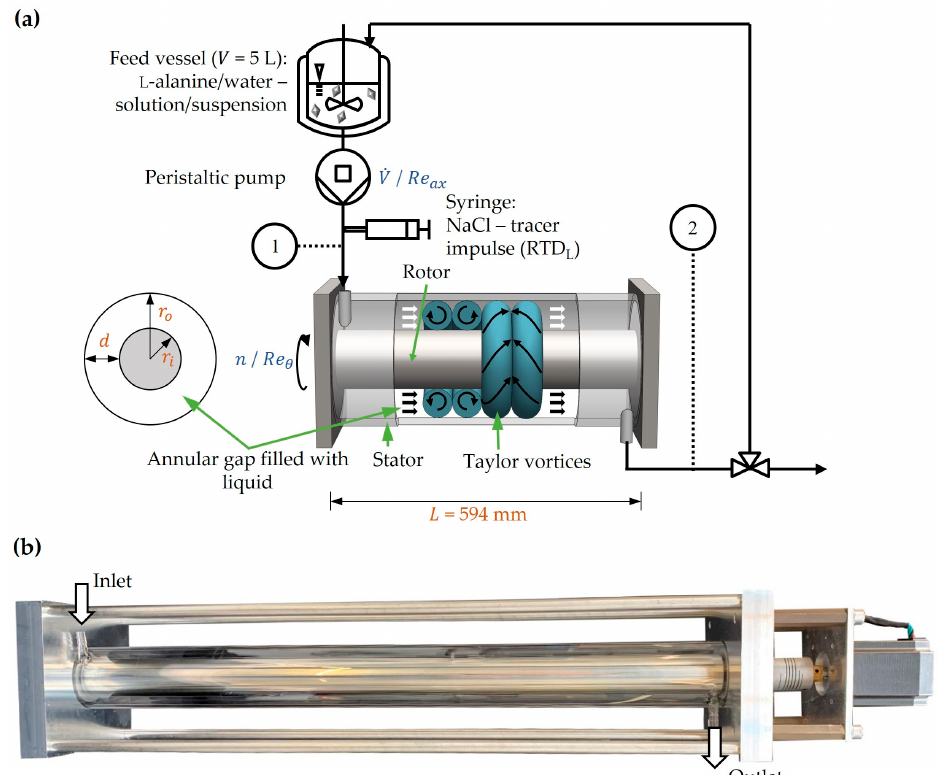
Figure 2. Illustration of the employed set‑up. ( a ) Schematic depiction. Current measurement probes were integrated at positions 1 and 2 to measure the RTD L . A three‑way valve behind the TCC’s outlet could be used to convey either a circuit back into the feed vessel or a waste container. Operating and design parameters are shown in blue and orange, respectively. ( b ) Photograph of the TCC. The end plates were held in place by four steel rods. The motor was fixated on one end plate and connected to the rotor by a spring clutch.